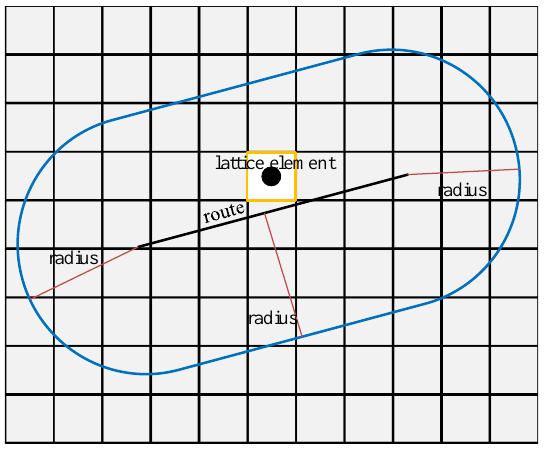
Figure 3. Road network kernel density.